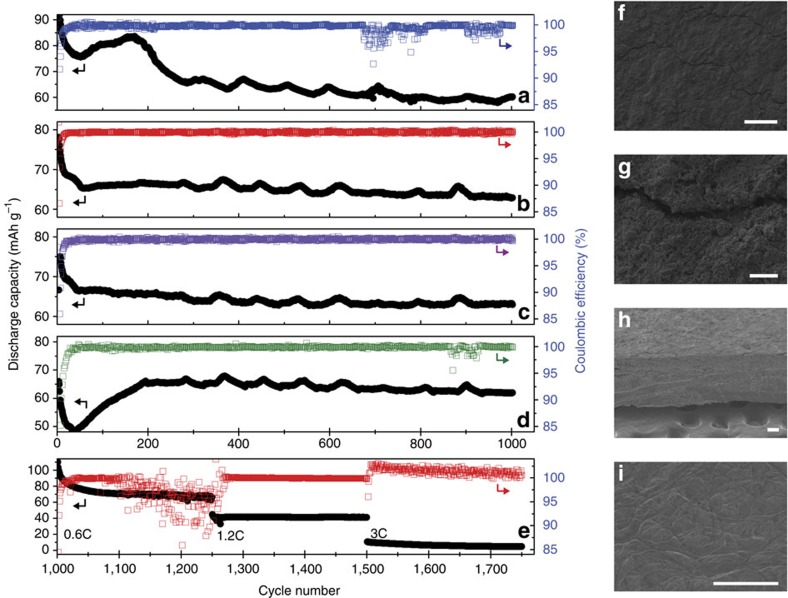
Electrochemical performance of LiFePO4 versus pristine and tailored lithium anodes after 12-day pretreatment with ionic liquid electrolytes.Discharge capacity and Coulombic efficiencies of Li|electrolyte|LiFePO4 full cells versus cycle number cycle at 1-c rate assembled with (a) pristine lithium and LiFSI|[C3mPyr+][FSI−] electrolyte. Discharge capacity and Coulombic efficiency for cells with LiFSI|[C3mPyr+][FSI−] electrolyte and pretreated with electrolytes composed of (b) LiFSI/[C3mPyr+][FSI−] (c) LiPF6/[C3mPyr+][FSI−] and (d) LiAsF6/[C3mPyr+][FSI−]. (e) Discharge capacity and Coulombic efficiency for the same LiFSI|[C3mPyr+][FSI−] cell in (b) after a shelf-life of 330 days. SEM micrographs of the LiFSI|[C3mPyr+][FSI−] cell (f), lithium anode (g), higher magnification (scale bar, 10 μm) of (f), (h) cross-section of (f) and (i) separator material. All other scale bars, 100 μm.